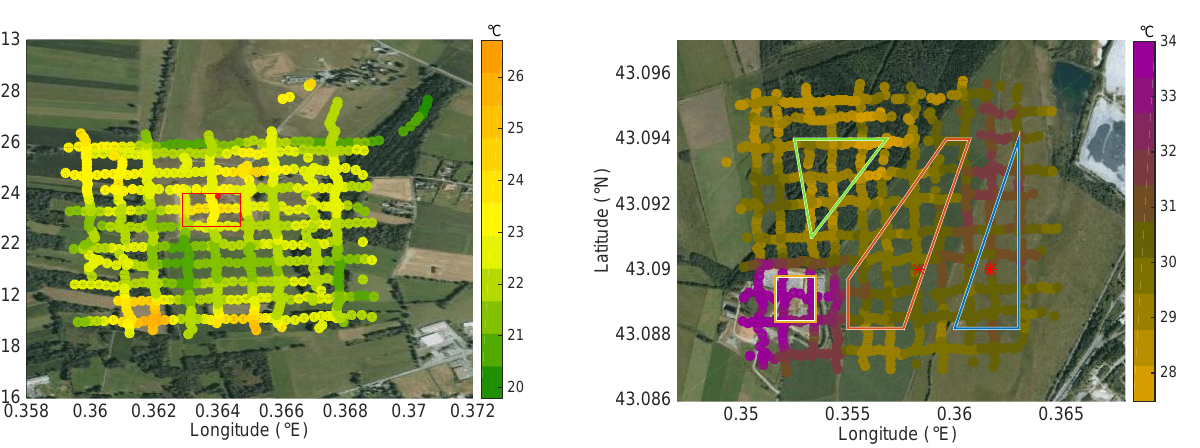
Figure 11. Surface temperature from Site 2 on 27 June 2011 at 13:15UTC measured using the downward-looking SUMO IR sen- sor. Data are only shown for the straight flight legs, where the IR sensor is assumed to look vertically down. Four areas with charac- teristic surface types are marked with coloured boxes: moor (blue), corn (red), forest (green), waste site (orange). The locations of two net radiometers (AWS) within the moor and corn areas are marked as well.